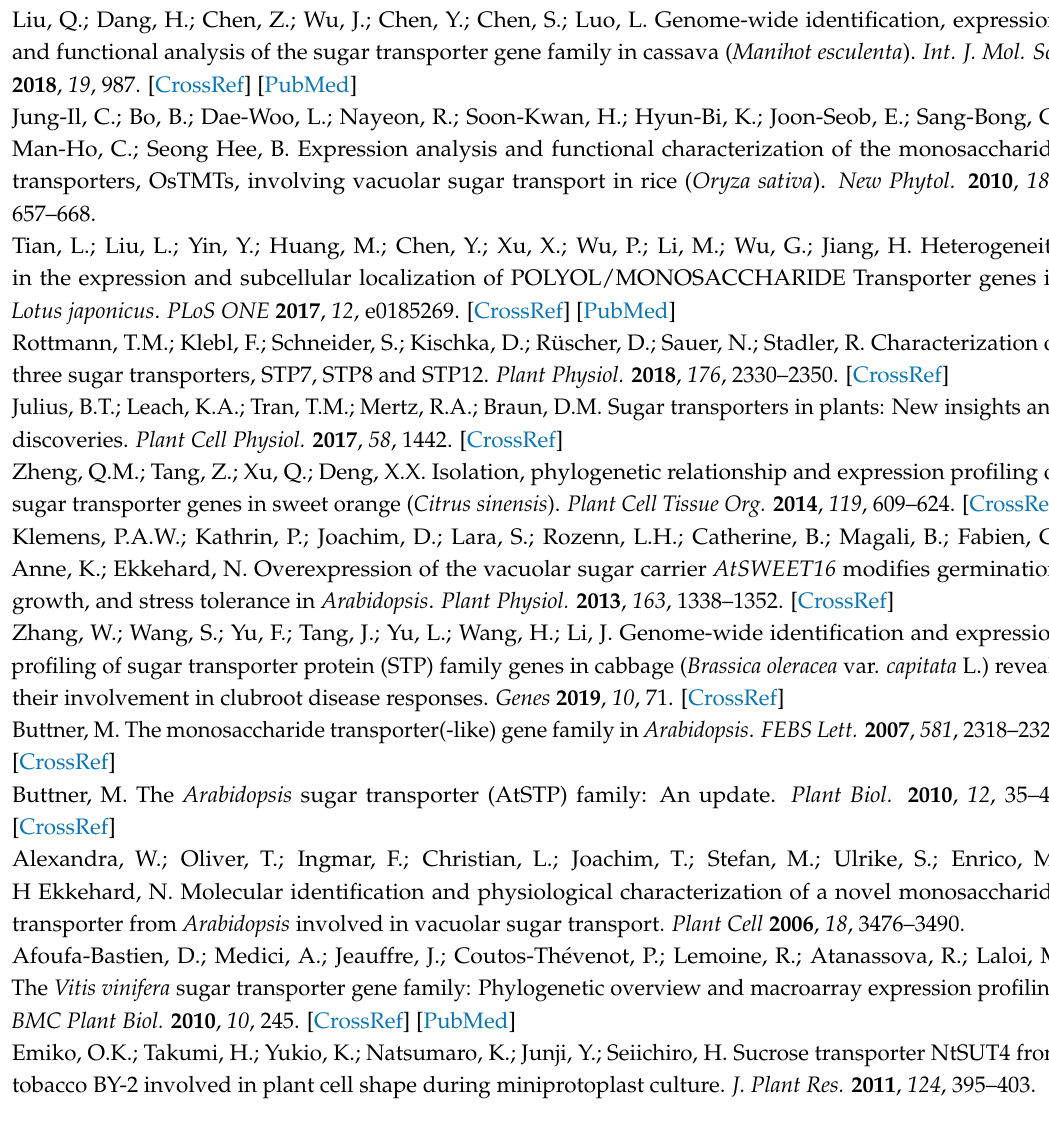
Table S1: Primers of MST genes for qRT-PCR in this study. Figure S1. The Maximum Likelihood (ML) tree for MST genes in